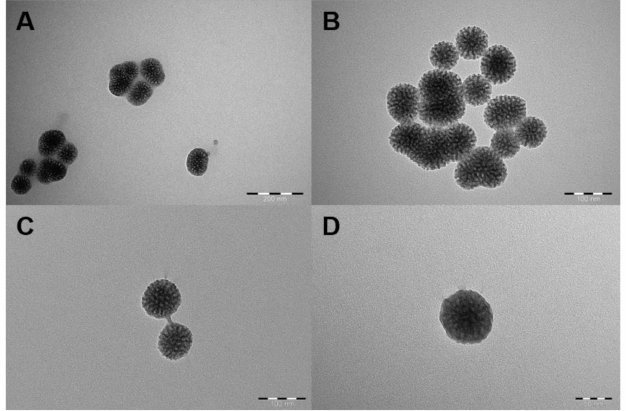
Figure 3. TEM images representing PDDMA polymer-encapsulation results. A: F2, B: F3, C: F6, and D: F7. Scale bars: ( A ) 200 nm, ( B ) and ( C ) 100 nm, and ( D ) 50